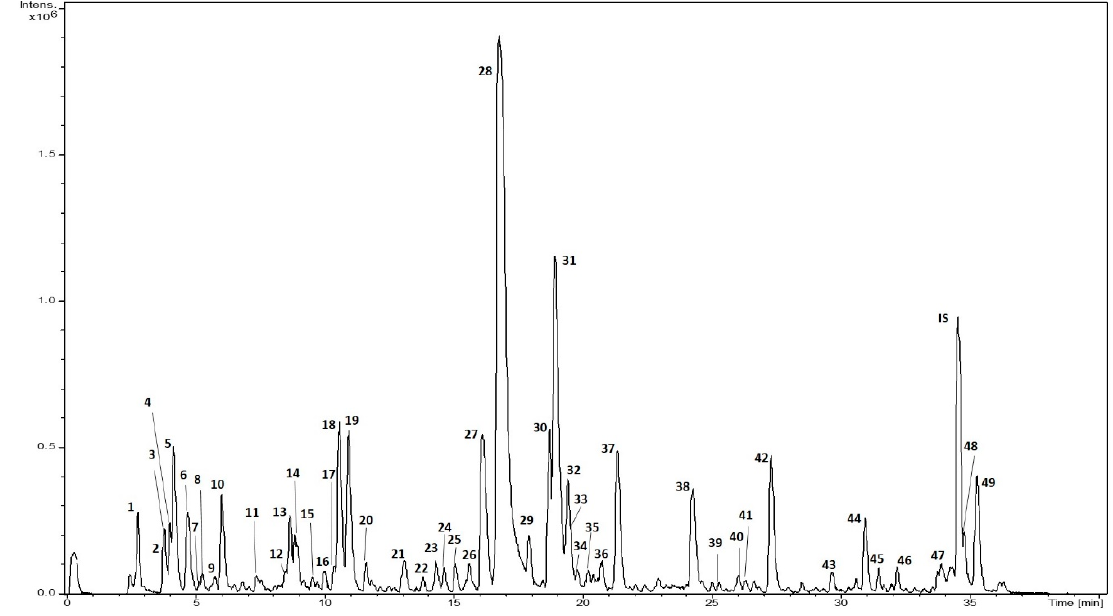
Figure 1. Base peak chromatogram of L. citriodora extract.